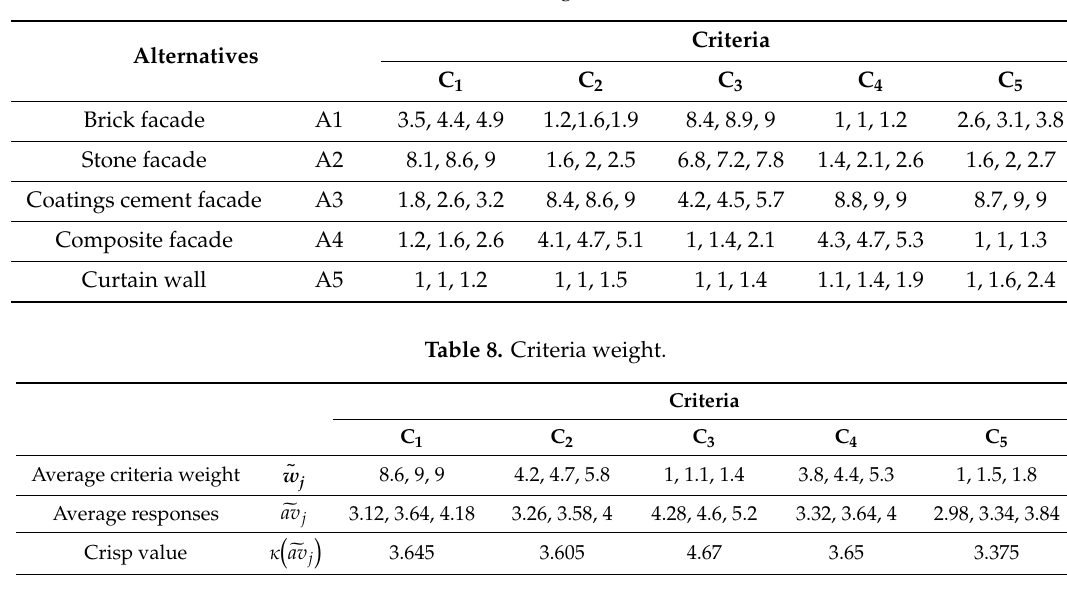
Table 7. Average distance.